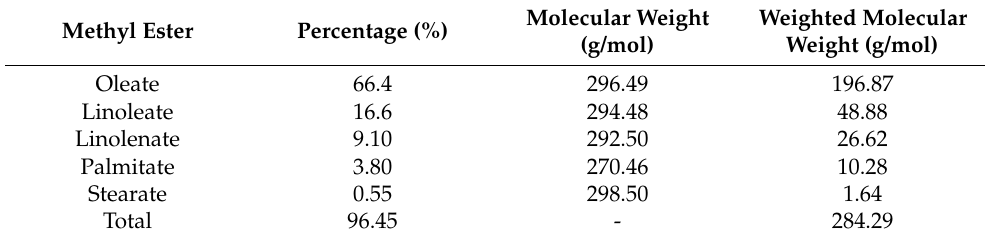
Table 4. Average molecular weight of rapeseed